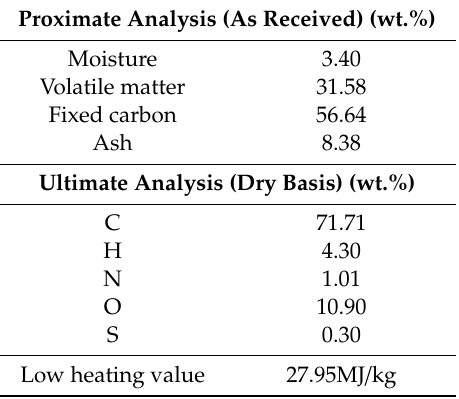
Table 1. Coal properties.